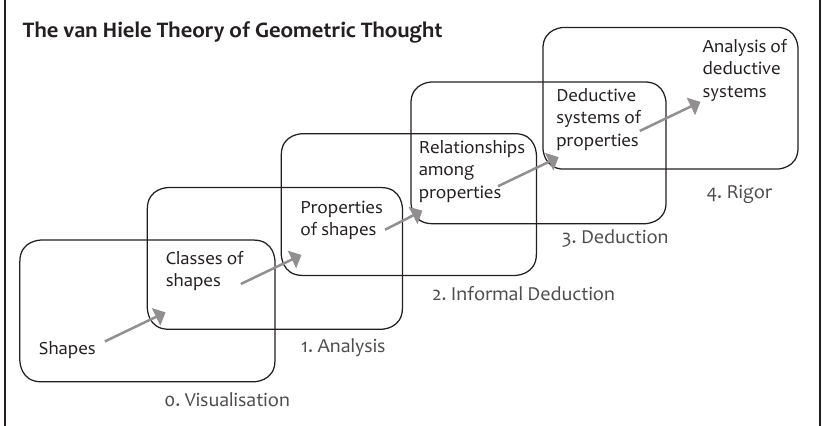
Figure 1: The Van Hiele theory of geometric thought (Van de Walle 2004:347) Van Hiele’s levels provide teachers with a framework in which to conduct geometric activities by designing them with the assumptions of a particular level in mind. It also allows them to ask questions that are below or above a particular level (Van de Walle 2004). Van Hiele’s (1986) theory of geometric knowledge, with its focus on geometric reasoning, has been linked to Piaget’s five stages of child development in terms of the role they play in learning geometry (Pusey 2003). However, Van Hiele’s levels of geometric knowledge are not age-specific or age-dependant, which suggests that learners’ progression from one level to the next is dependent on the effectiveness of the teaching and content acquisition opportunities that they are exposed to (Frobisher et al